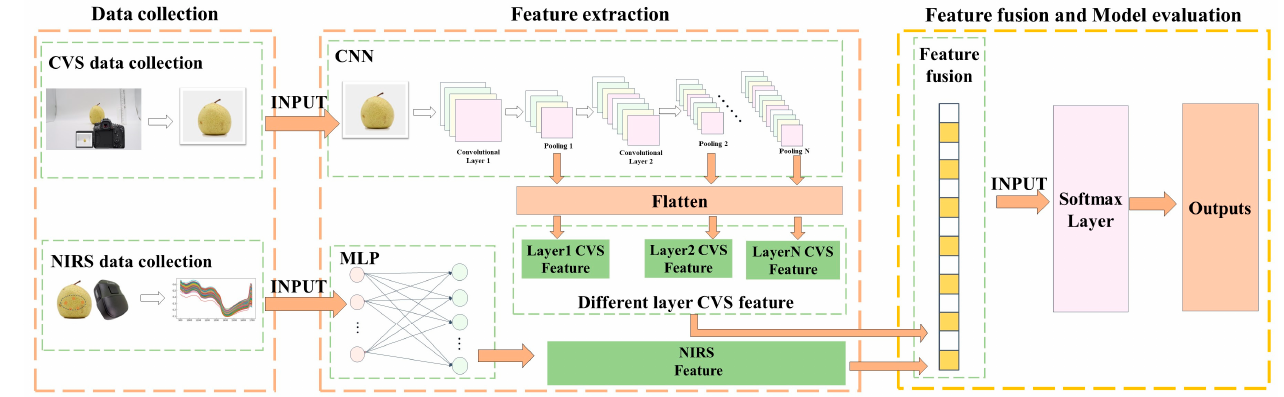
Figure 5. Description of spectral and image feature depth fusion methods.